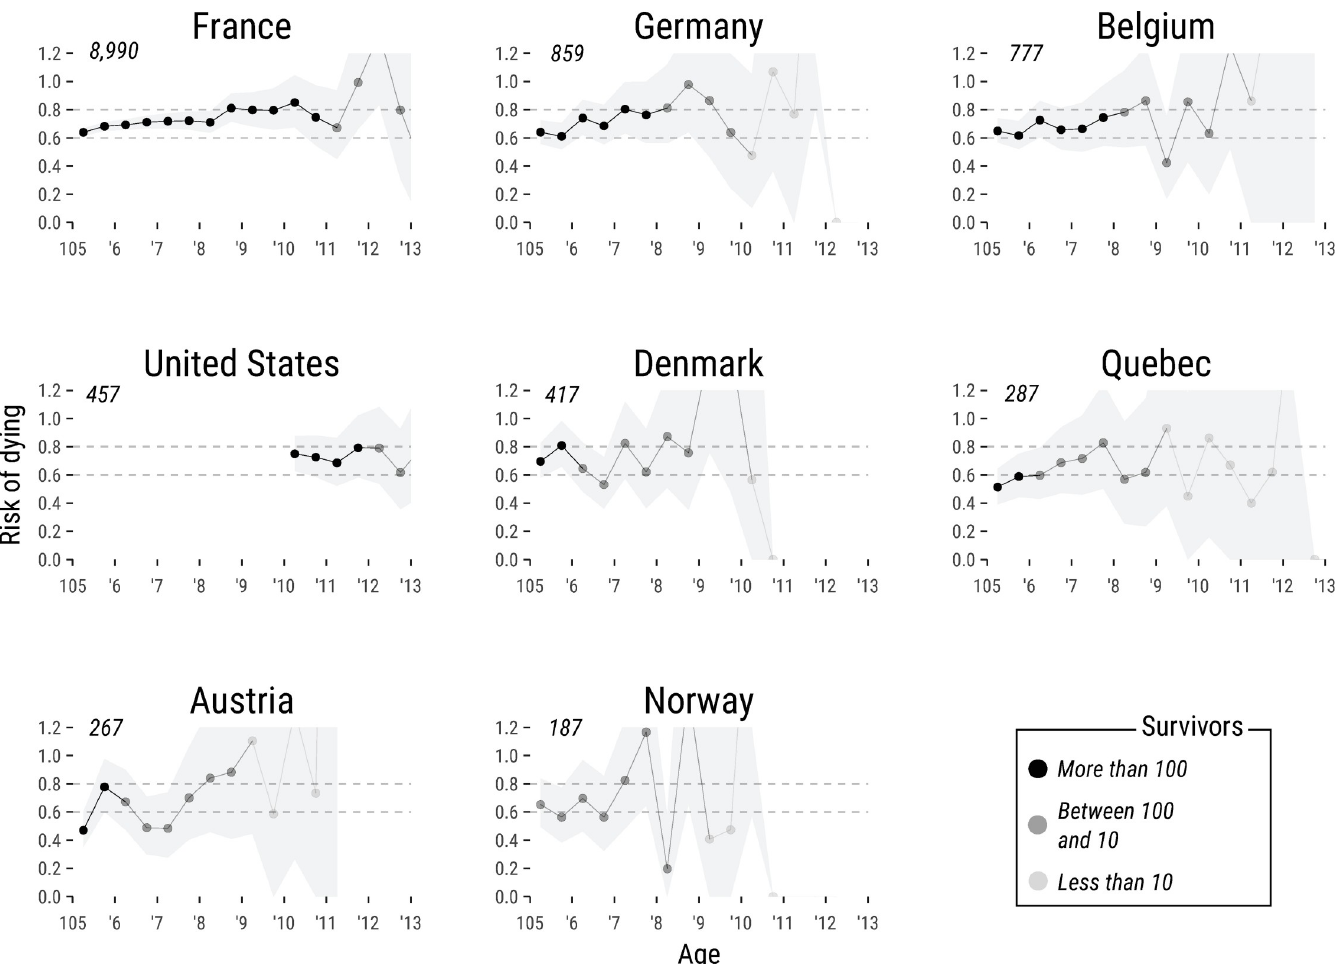
Fig 2. Risk of dying between ages 105 and 113 with 95% empirical confidence intervals for females. The estimation of the risks of dying and empirical confidence intervals was performed using a fully non-parametric approach and by considering the observations schemes in each country. The risk of dying is expressed in age intervals of six months. Population size is indicated at the top-left corner of each panel. The darker the shade of the dot plot, the greater the number of survivors at every specific age (i.e. subjects exposed to the risk of dying). For example, at age 105, there were 8,990 French females exposed to the risk of dying. At age 113, only 18 survived.